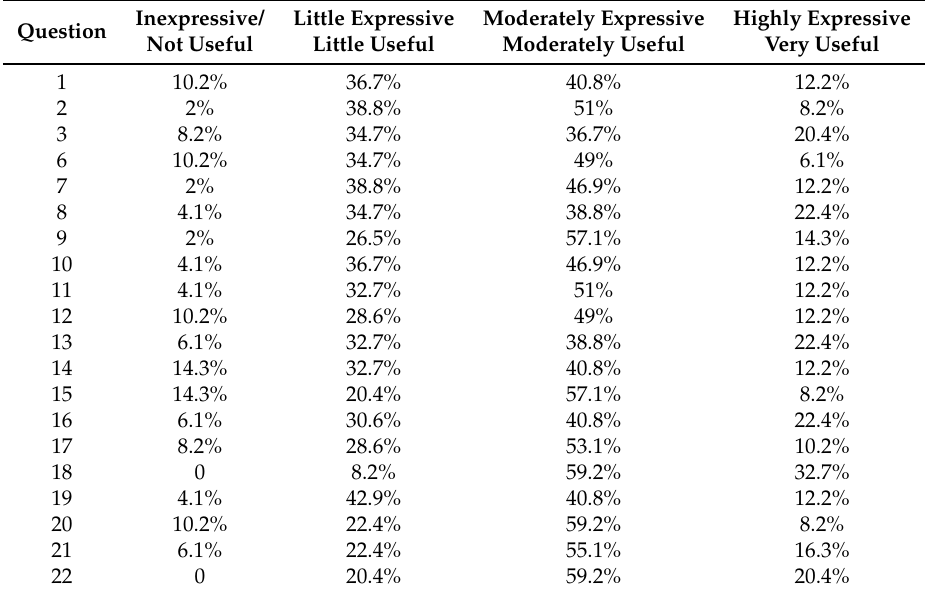
Table 1. Question Results.